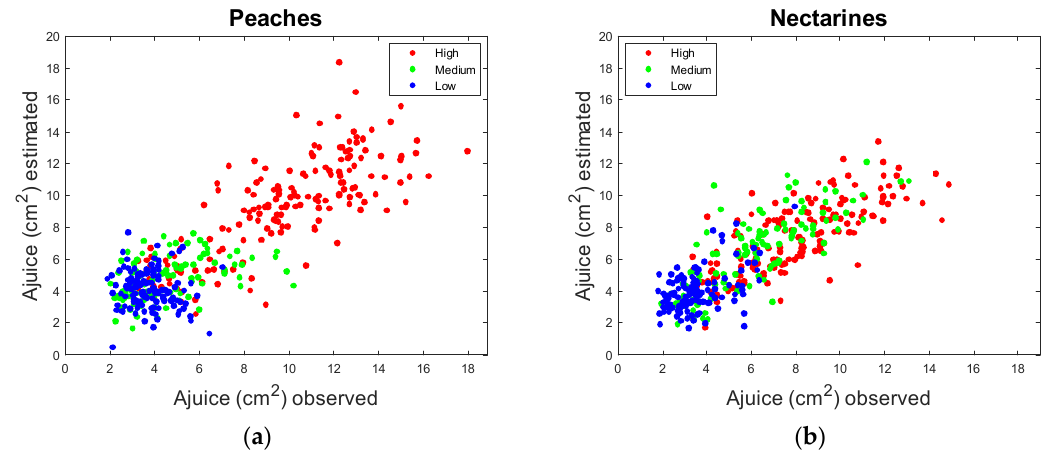
Figure 6. Prediction of instrumental juiciness (Ajuice) for ( a ) peaches and ( b ) nectarines in absorbance mode without preprocessing. Colors denoted the category of sensorial juiciness (high, medium, and